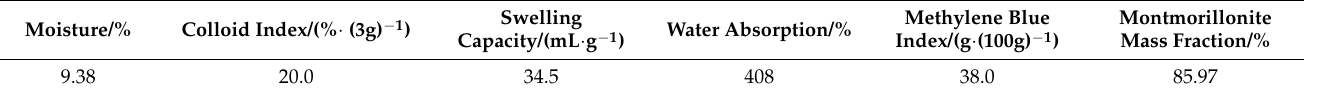
Figure 4. XRD pattern of Guisha limonite. Table 3. The chemical composition of bentonite used in the Table 2. Iron ore chemical composition.